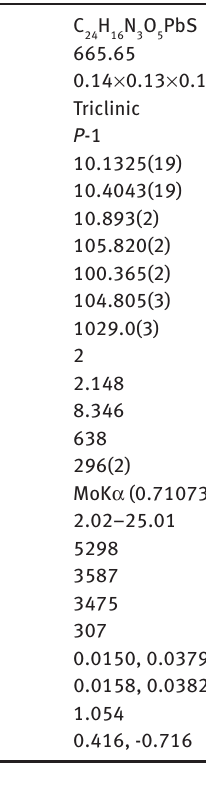
Table 4 Crystal data and refinement parameters.